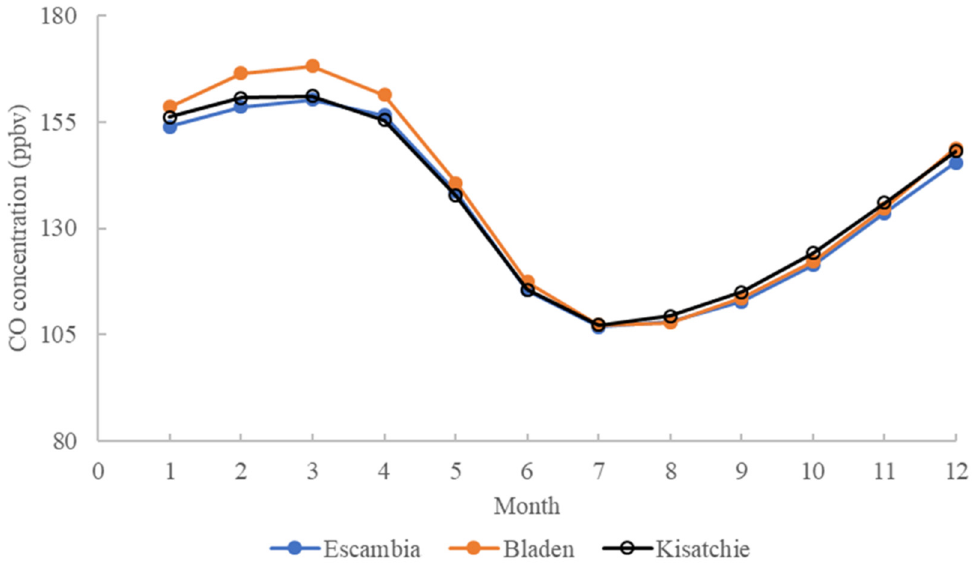
Figure 6. The integrated monthly CO concentration in air at night time in the three areas.